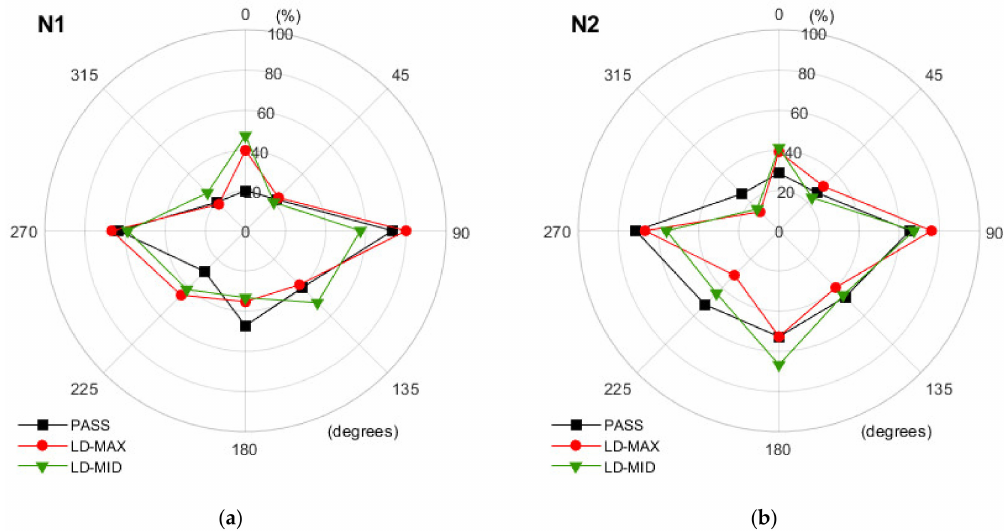
Figure 7. The values of the direction recognition index determined for different directions when using earmuffs in different modes: ( a ) N1 and ( b ) N2. PASS—with the level-dependent system switched off. LD-MAX—level-dependent mode, with maximum amplification in the sound transmission path; LD-MID—level-dependent mode with the amplification set to incomplete (approximately